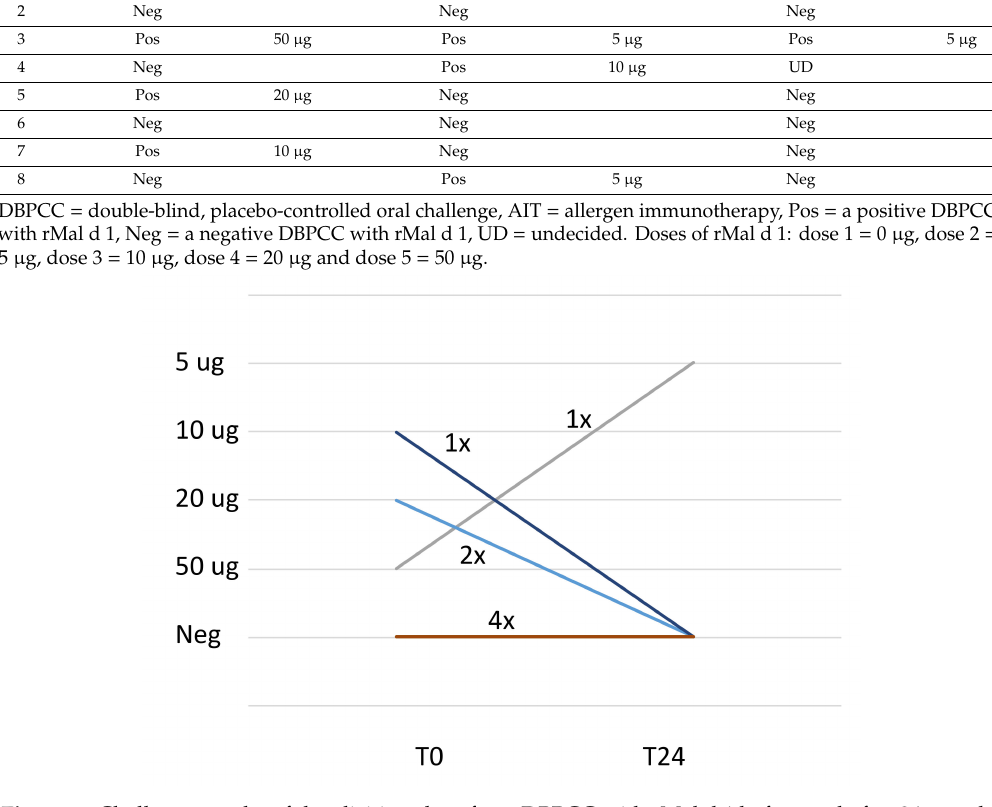
Figure 5. Challenge results of the eliciting-dose from DBPCC with rMal d 1 before and after 24 months of BP-AIT. Neg (4 × ): In four patients the DBPCC with rMal d 1 was negative at T0 and